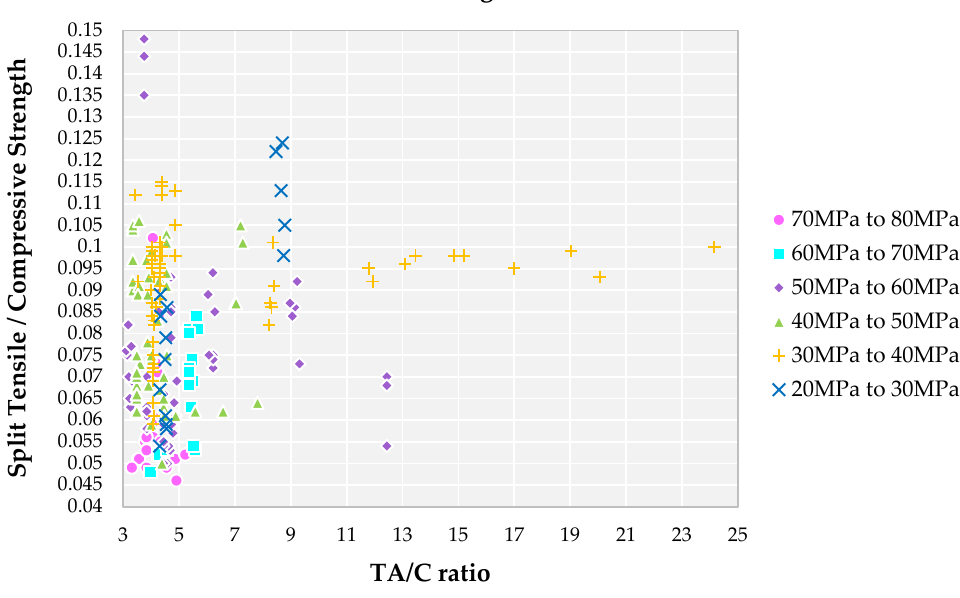
Figure 7. Impact of TA/C ratio on split tensile strength to compressive strength ratio for different grades of SCC concrete with recycled aggregate according to literature.